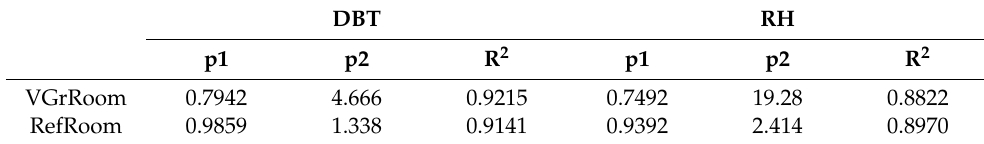
Table 5. Results of the linear fitting.